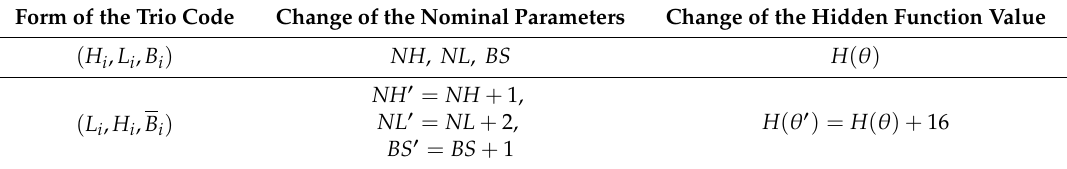
Table 1. Rule of adjusting hidden function value by nominal